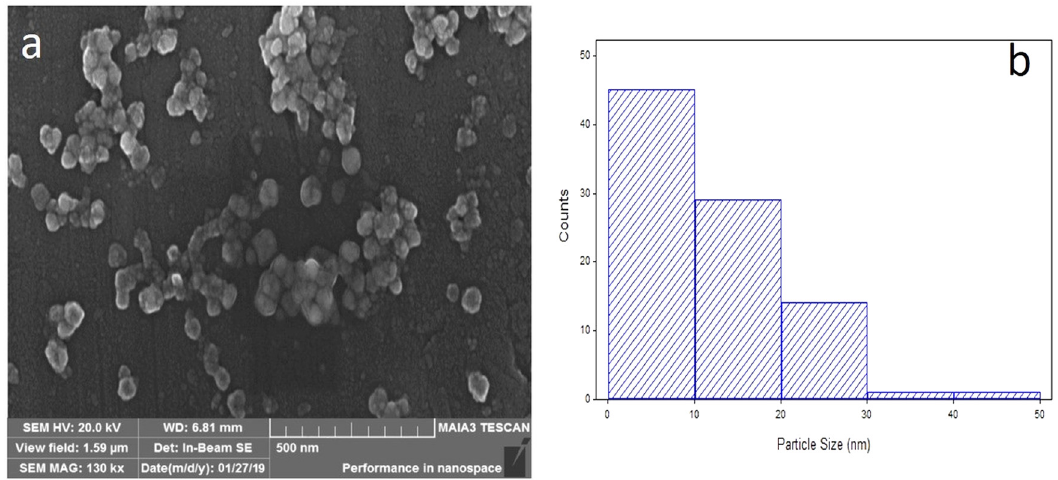
Figure 4: SEM micrograph of Ag - NPs: ( a ) from leaf of O. ferrugniea and ( b ) particle size